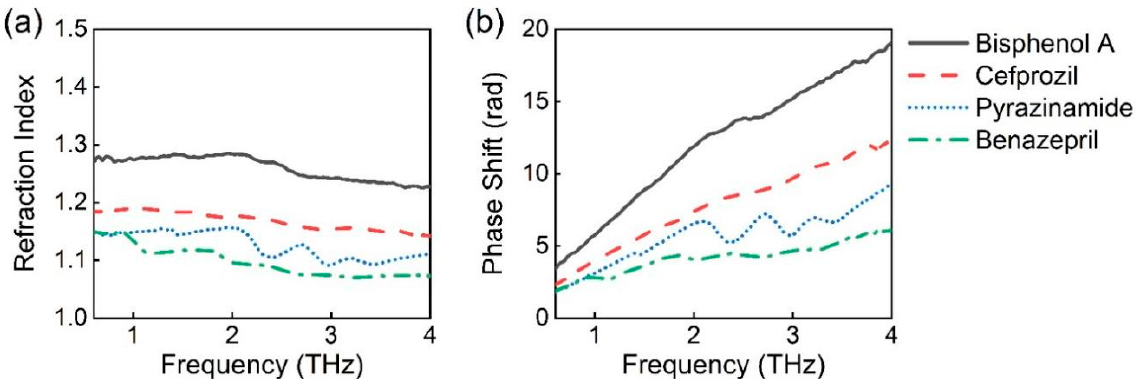
Figure 2. THz characteristic spectra of four samples. THz TDS system tests ( a ) Refractive index spectrum and ( b ) the phase spectrum of the four samples.